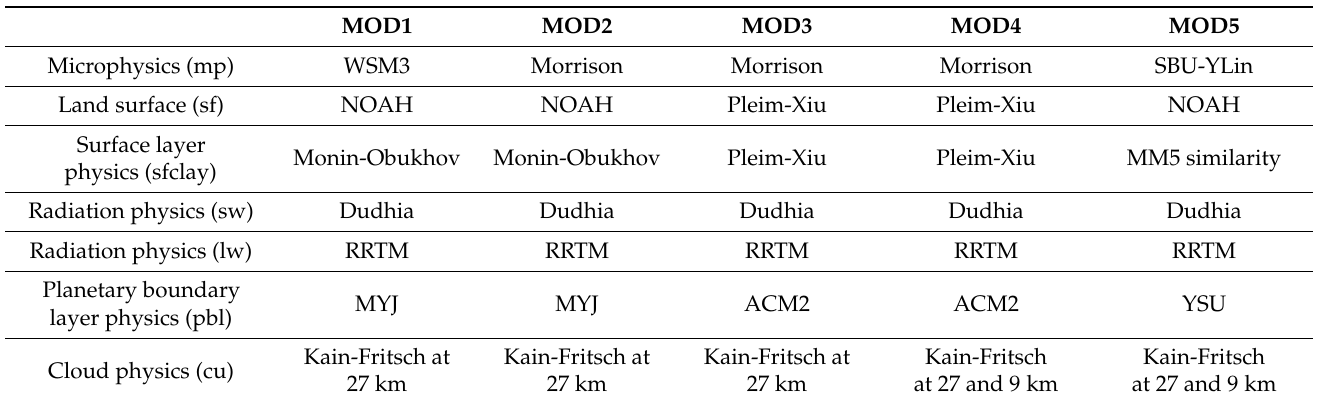
Table 2. WRF parameterization options used for the PaTrop sensitivity analysis.